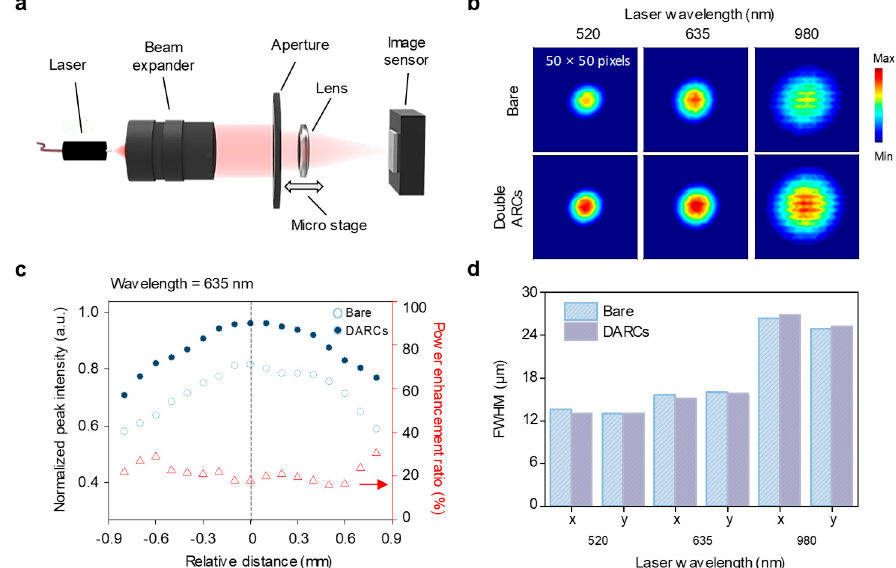
Figure 4. ( a ) Schematic illustration of optical setup for estimating the imaging characteristics of a single lens. ( b ) Beam profile (50 × 50 pixels; 83.5 μ m × 83.5 μ m) of a single SF11 bare lens and SF11 DARCs lens using various laser diodes with wavelengths of 520, 635, and 980 nm. ( c ) Plot of normalized peak intensity and power enhancement ratio of a SF11 bare lens and DARCs lens as a function of the relative displacement of the lenses. Dashed line shows unchanged focal length. ( d ) Comparison of full width at half maximum (FWHM) in Figure 4b in terms of x and y directions.